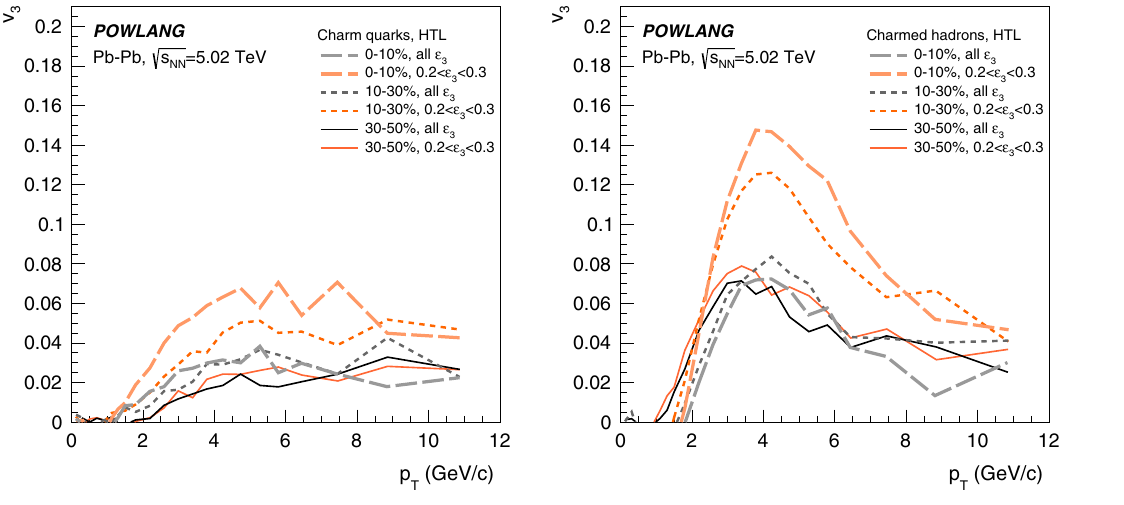
Fig. 15 The triangular-flow coefficient v 3 of charmed quarks (left panel) and hadrons (right panel) in Pb–Pb collisions at TeV for various centrality classes. For each class we display results referring to the fixed eccentricity interval 0 . 2 ≤ (cid:7) 3 ≤ 0 . 3 and to an unbiased selection of the events. At the quark level results for events